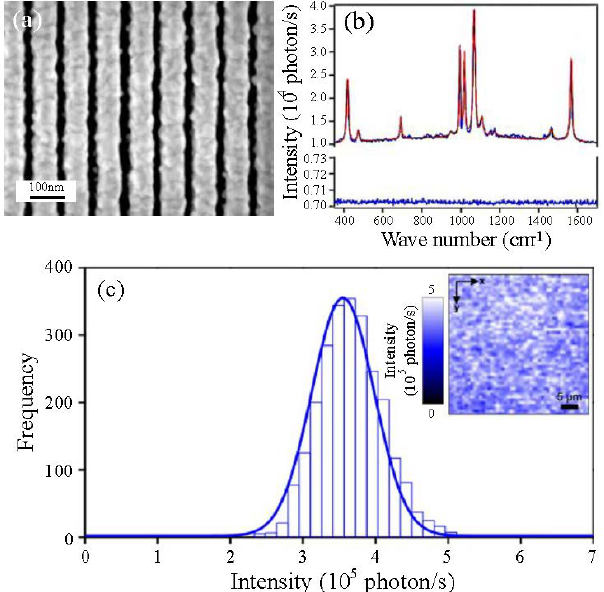
Figure 13: (a) Image of the Au nanowire array surface. (b) Mea- sured SERS spectra of BT chemisorbed on a Au nanowire array (top) and flat-Au surfaces (bottom). The red curve indicates the fitted Lorentzian bands. (c) Histogram of 1068 cm −1 band integrated in- tensity from the Raman mapping over a 40 × 40 µ m 2 area (inset) and fitted Gaussian distribution. Adapted from Ref.